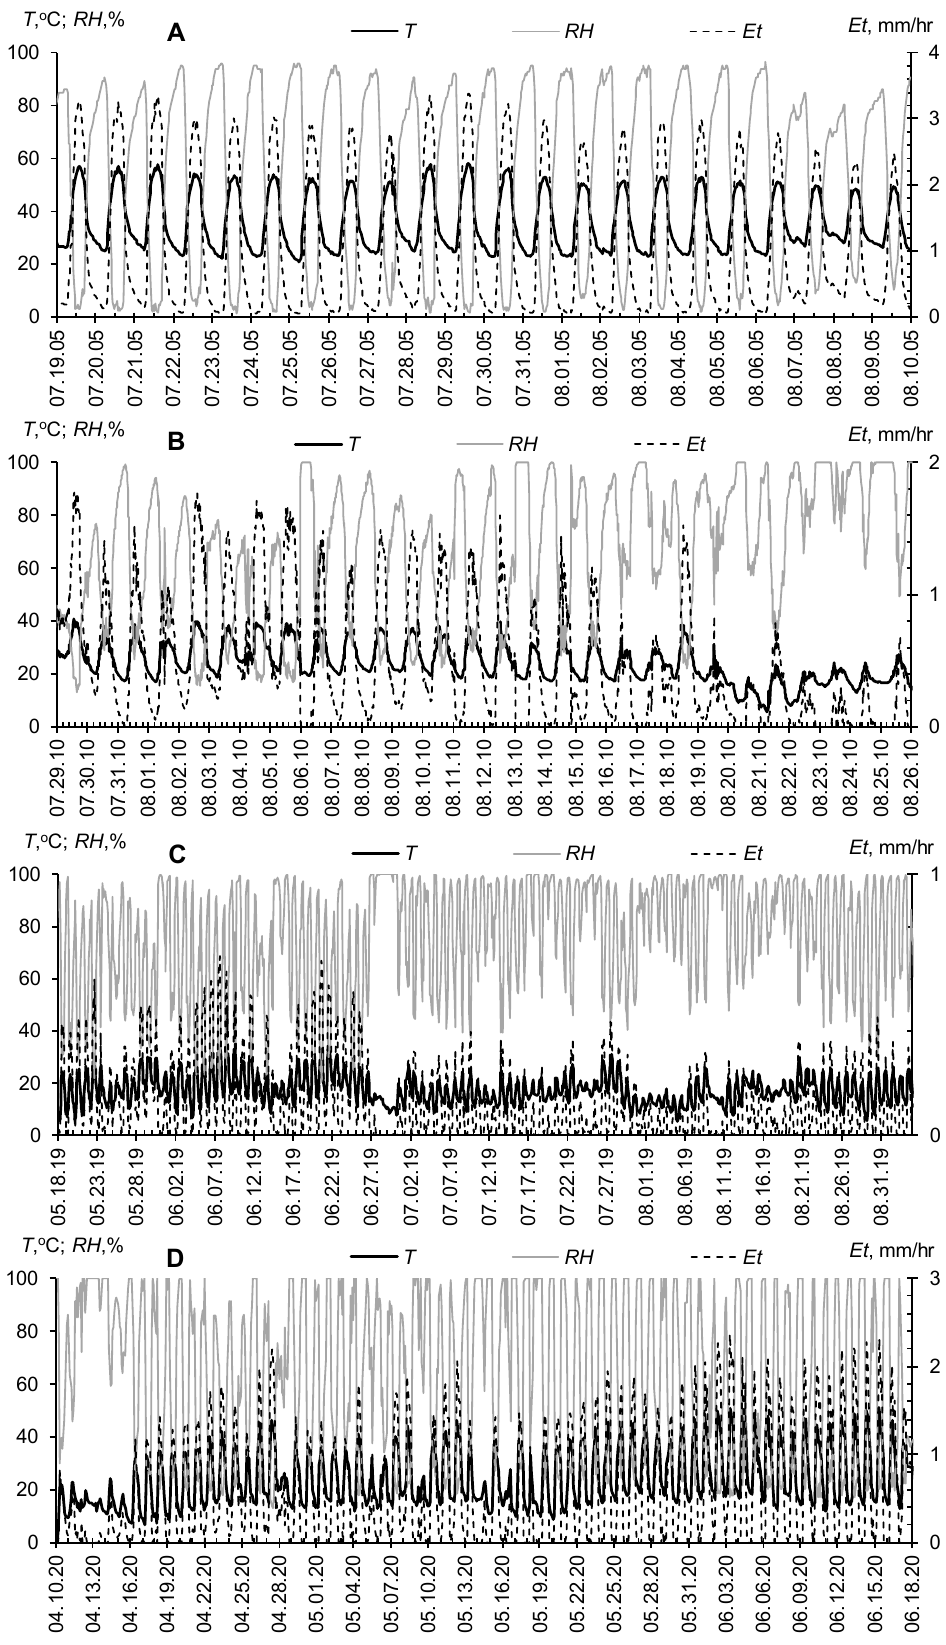
Figure 3. Weather conditions of the growing season (DS1923 monitoring fragments): ( A )—Qatar (2005); ( B , C )—Moscow region (2010, 2019); ( D )—Uzbekistan (2020).